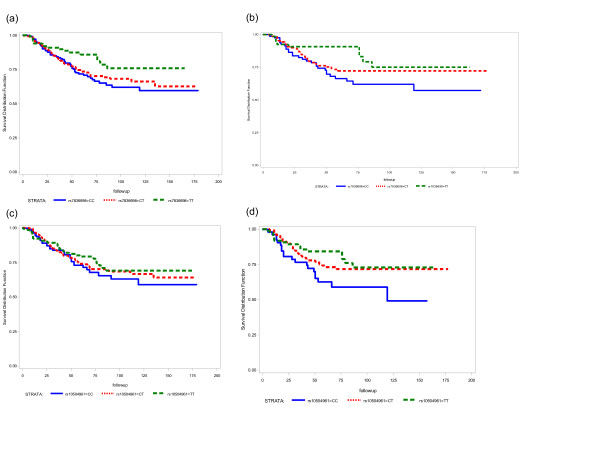
Kaplan-Meier estimates of CRC specific survival (months) according to UQCRB genotypes, (a) rs7836698, all CRC patients (n = 606), log rank p value = 0.07, (b) rs7836698, all patients diagnosed with colon cancer (n = 324), log rank p value = 0.05, (c) rs10504961, all CRC patients (n = 606), log rank p value = 0.55, and (d) rs10504961, all patients diagnosed with colon cancer (n = 324), log rank p value = 0.06.